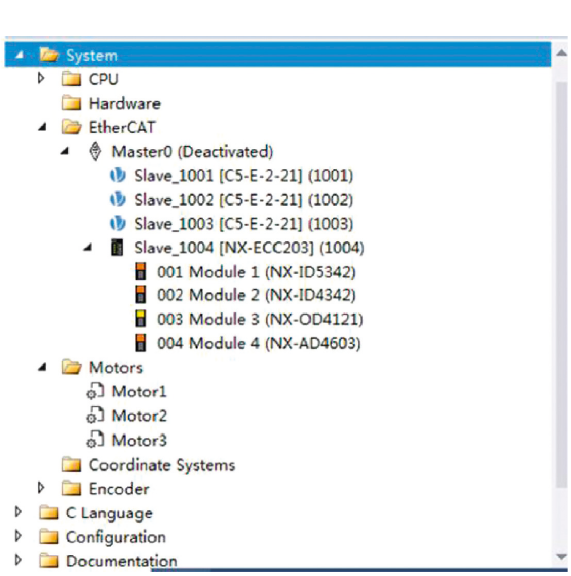
Figure 21: IDE programming